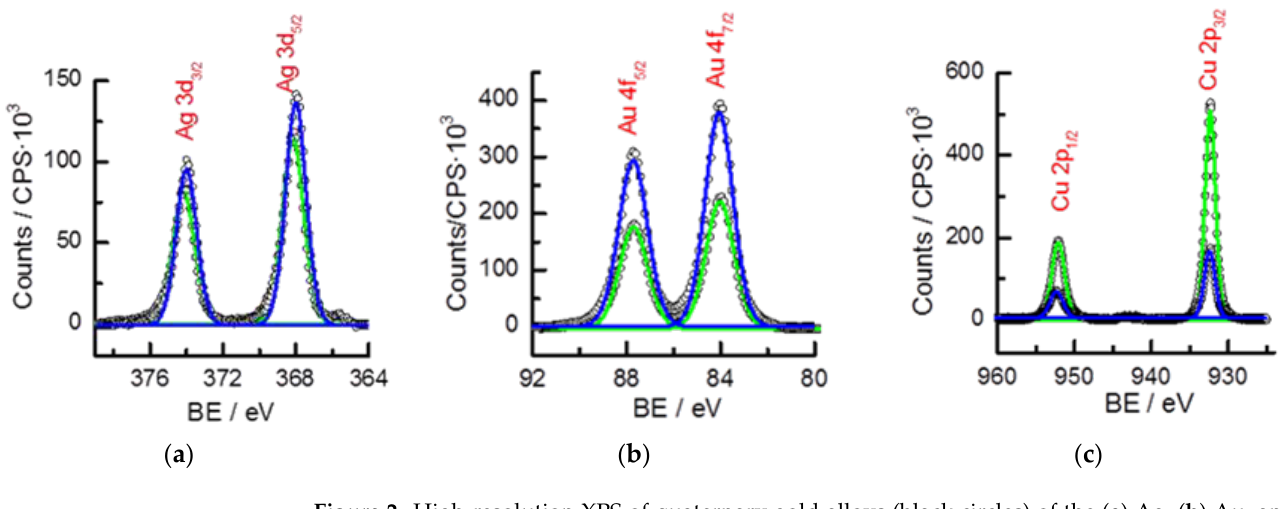
Figure 2. High-resolution XPS of quaternary gold alloys (black circles) of the ( a ) Ag, ( b ) Au, and ( c ) Cu bond energies. Regions of Ag3d, Au4f, Cu2p, and spin-orbit coupling. Deconvolution was obtained by Gaussian/Lorentzian curves. Gold alloy Au 18K (blue) and Au 9K (green).